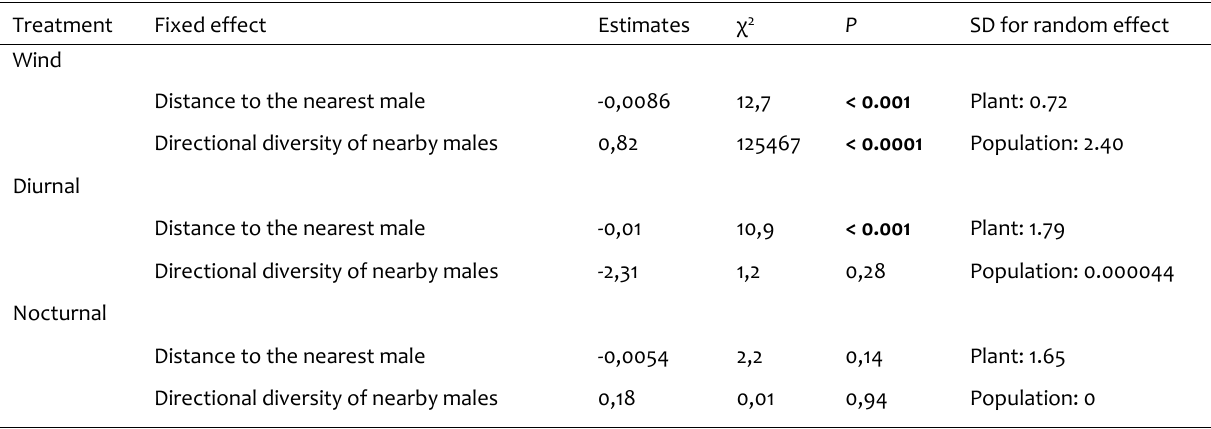
Effects of local mate availability on seed set of Salix caprea in different pollination treatments. Fixed effects were estimated in each GLMM for each treatment. A type II Wald chi-square test was performed for each estimate. SDs for the random effects were shown in the rightmost column as heuristic measures of variance among plants or populations compared to the fixed